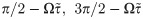
Delay-imposed populations of coupled heterogeneous phase oscillators.(A, B) In- and (C, D) anti- phase synchronized clusters, at frequency (A, C) Ω < μ and (B, D) Ω > μ. (a, b, e, f, i, j, m, n) Phases ϕi(t) of the synchronized (red and blue) and two unsynchronized oscillators (black) closest to the limits of synchronization, and ±(Ω − μ)t (dashed). (c, g, k, o) Geometric representation of ϕi of the synchronized oscillators (different shades of red diamonds for ωi < Ω and blue circles for ωi > Ω). Limits π/2-Ωτ˜,3π/2-Ωτ˜ and -Ωτ˜ are dashed red, the arrows are for the complex order parameter (black) of each subpopulation (they overlap for in-phase), angles Ωτ1,2 (blue), and Ωτ˜ and ΩΔτ (red). (d, h, l, p) PDF of the natural frequencies, frequency of synchronization Ω (black vertical line), and limits of synchronization (red). Entrained oscillators are blue and red, the first two un-synchronized on both sides are black, and the rest are green. The colors of each oscillator are consistent across the plots. Parameters: N = 300, K = 7, Lorentzian natural frequencies with μ = 1Hz and γ = 1. (A) τ = [0.05, 0.2]s, (B) τ = [0.7, 0.95]s, (C) τ = [0.22, 0.47]s, and (D) τ = [0.04, 0.27]s.